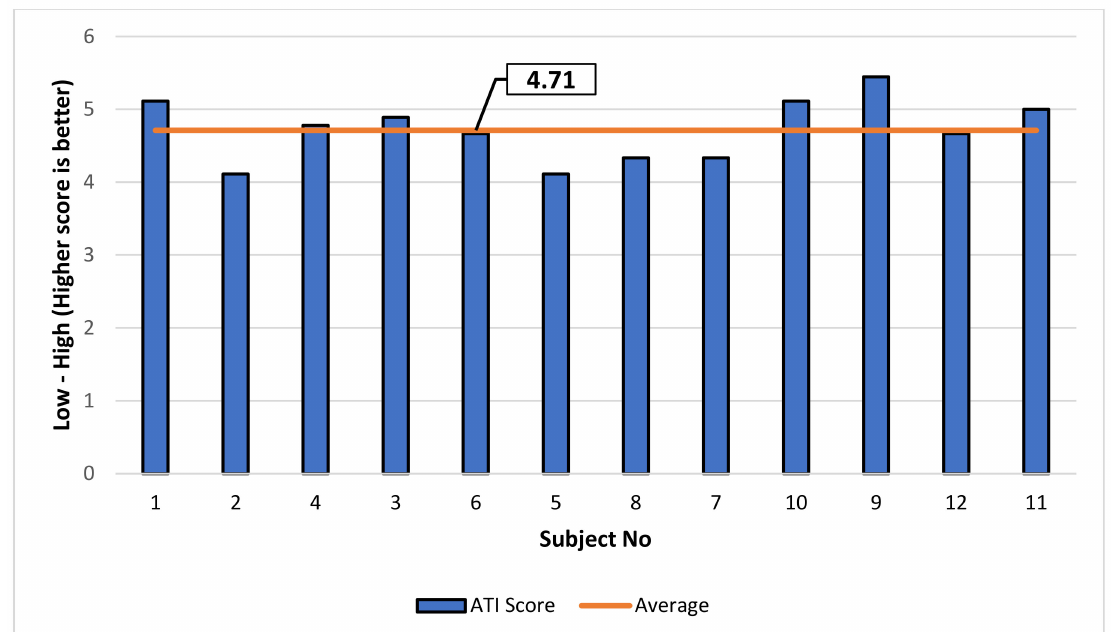
Figure 4. Individual Affinity for Technology Interaction (ATI) Scale Score.